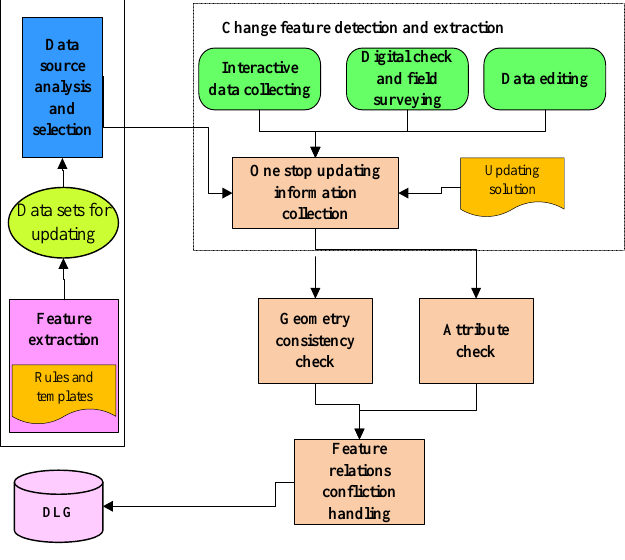
Figure 1. Change detection for updating from